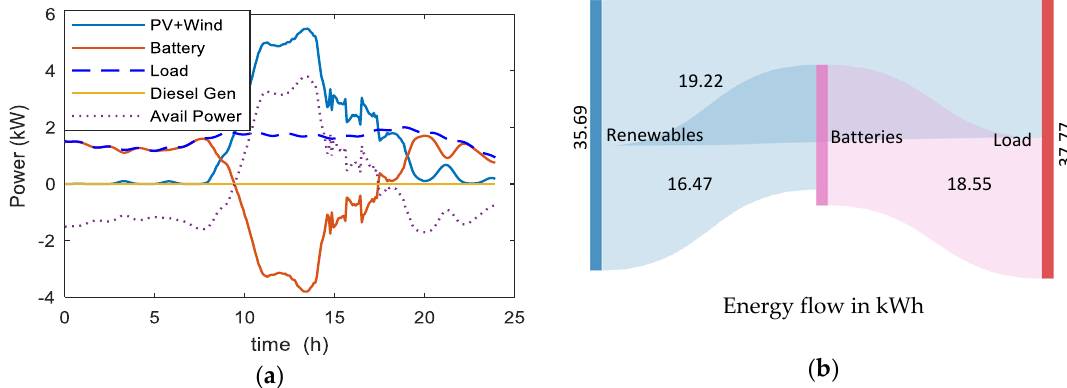
Figure 13. Node 2 at isolated operation (NMPC off) with unpredicted conditions: ( a ) Systems operation; ( b ) Energy flow (kWh).